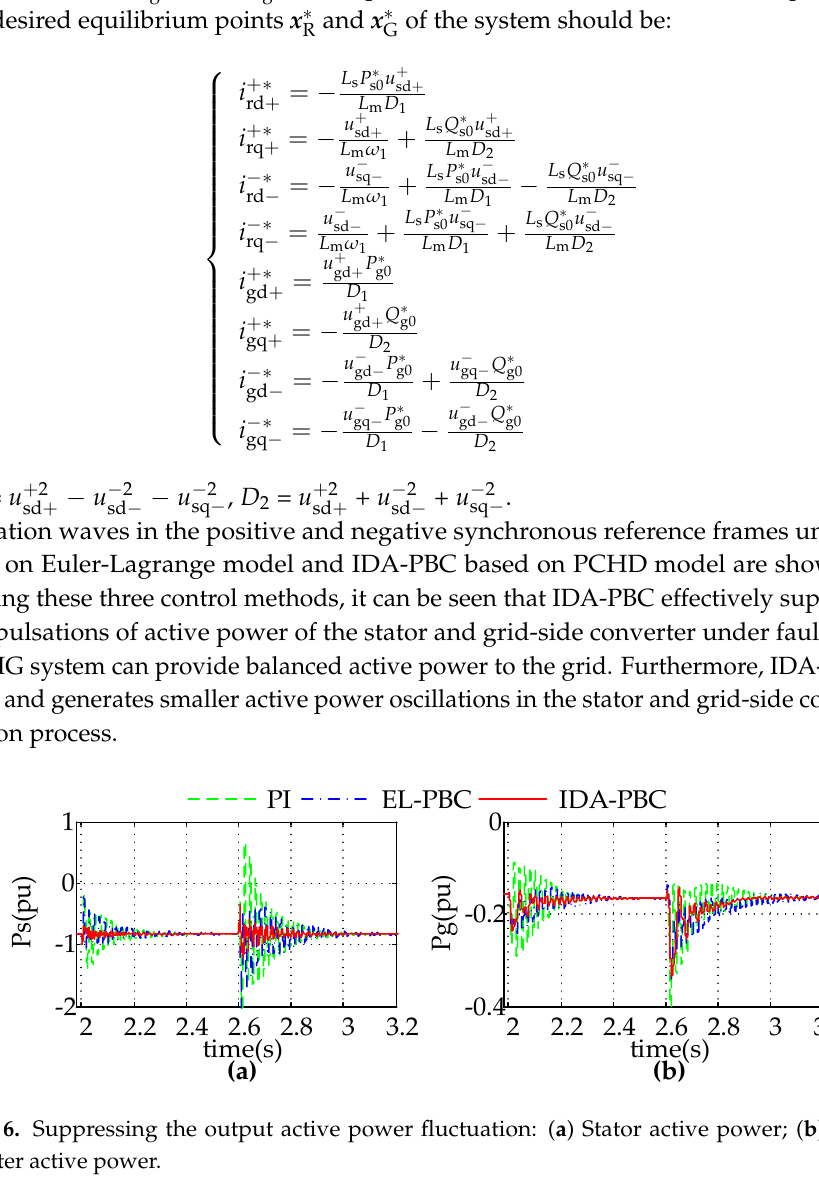
converter active